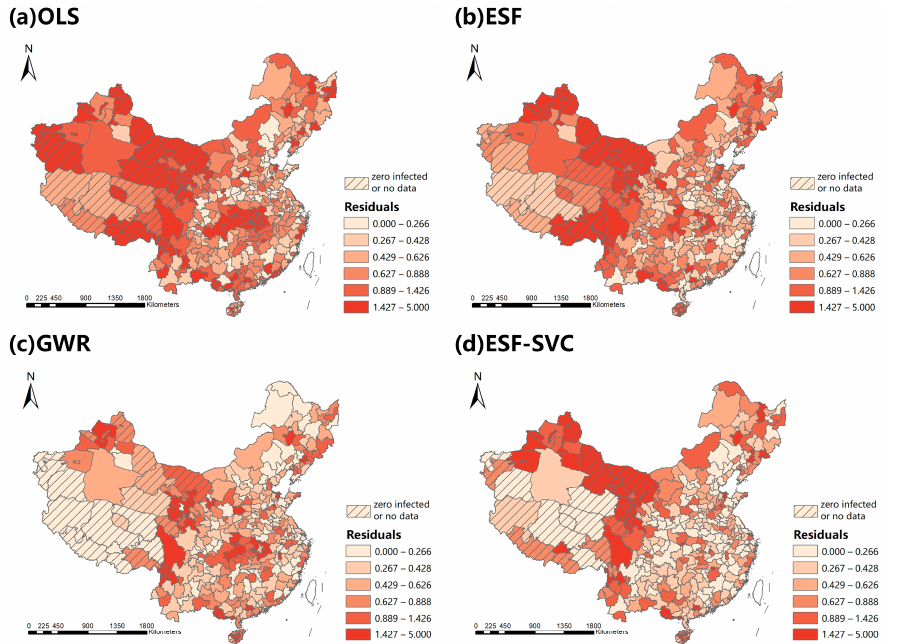
Figure 4. Residual maps for model fitted in Mainland China.